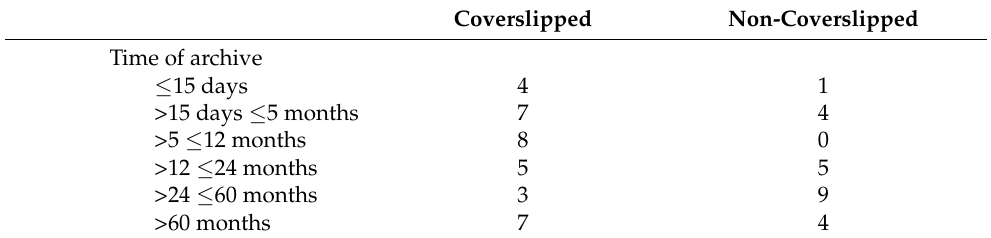
Table 2. Distribution of cases according to the pre-analytical variables time of archive and coverslipping. Coverslipped